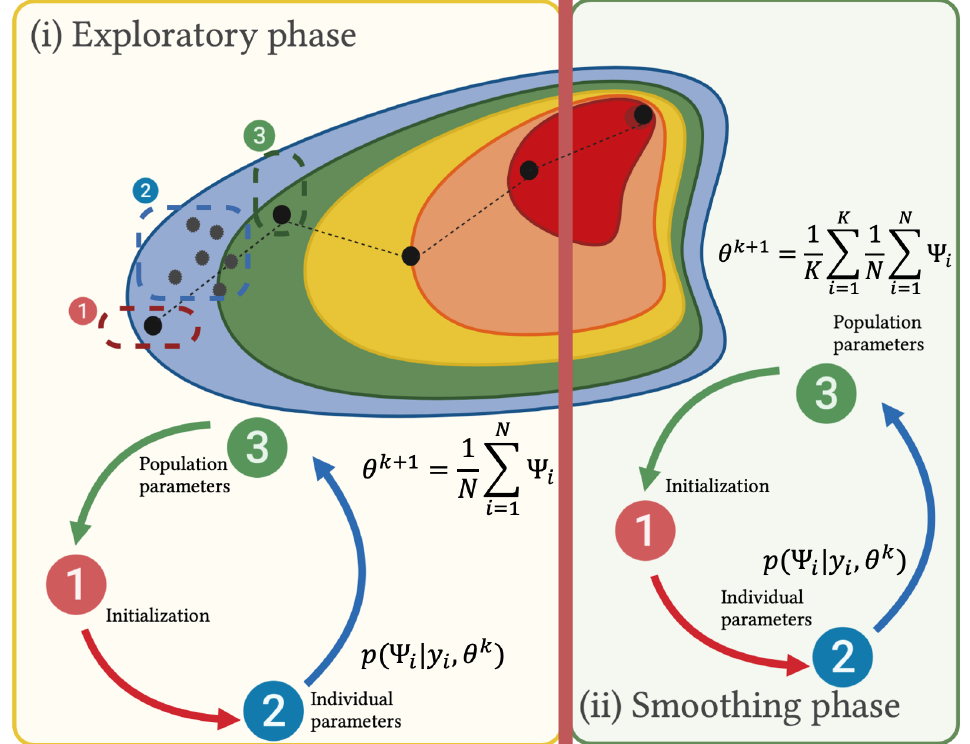
Figure 2. Graphical representation of the stochastic approximation version of the expectation- maximization algorithm (SAEM) in combination with the MCMC method. To ensure the global optimization solution, SAEM proceeds through two distinct steps: (i) the exploratory phase, during which the entire parameter space is explored, and (ii) the smoothing phase, during which the optimal solution is